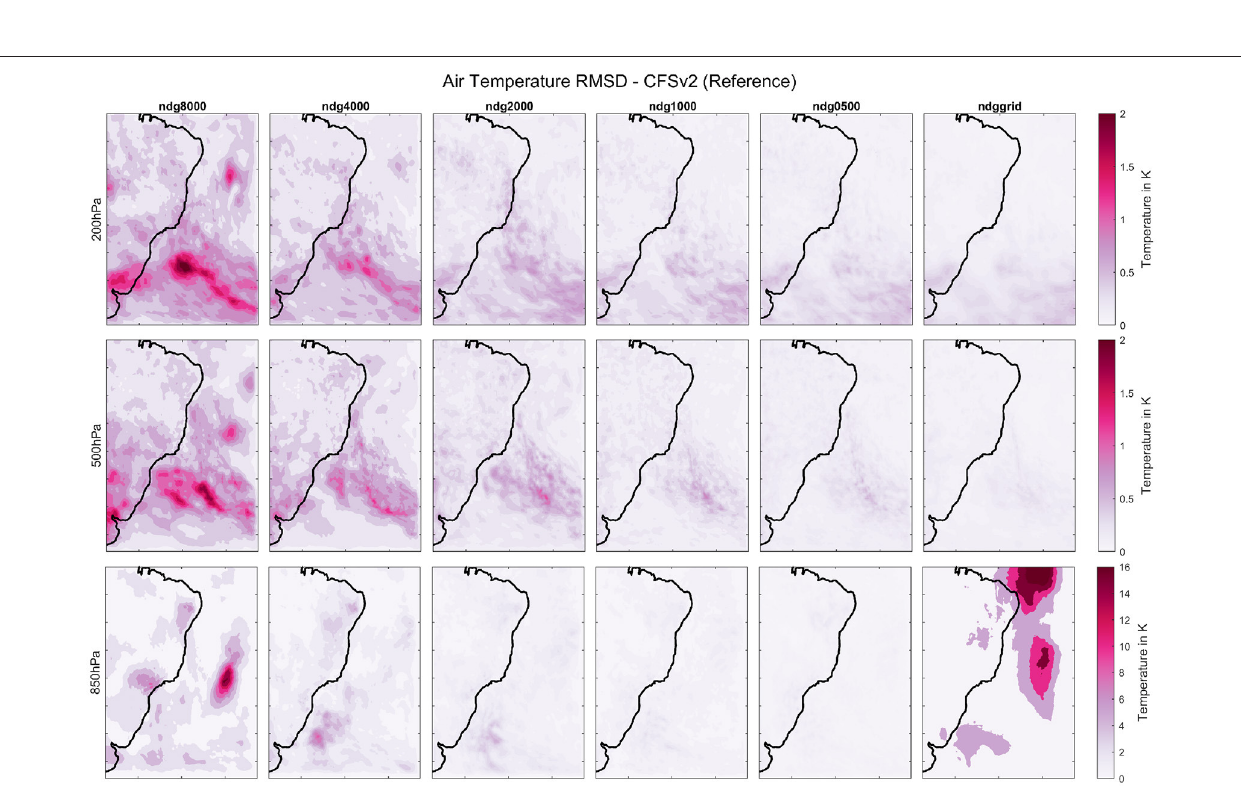
Frontiers in Earth Science |